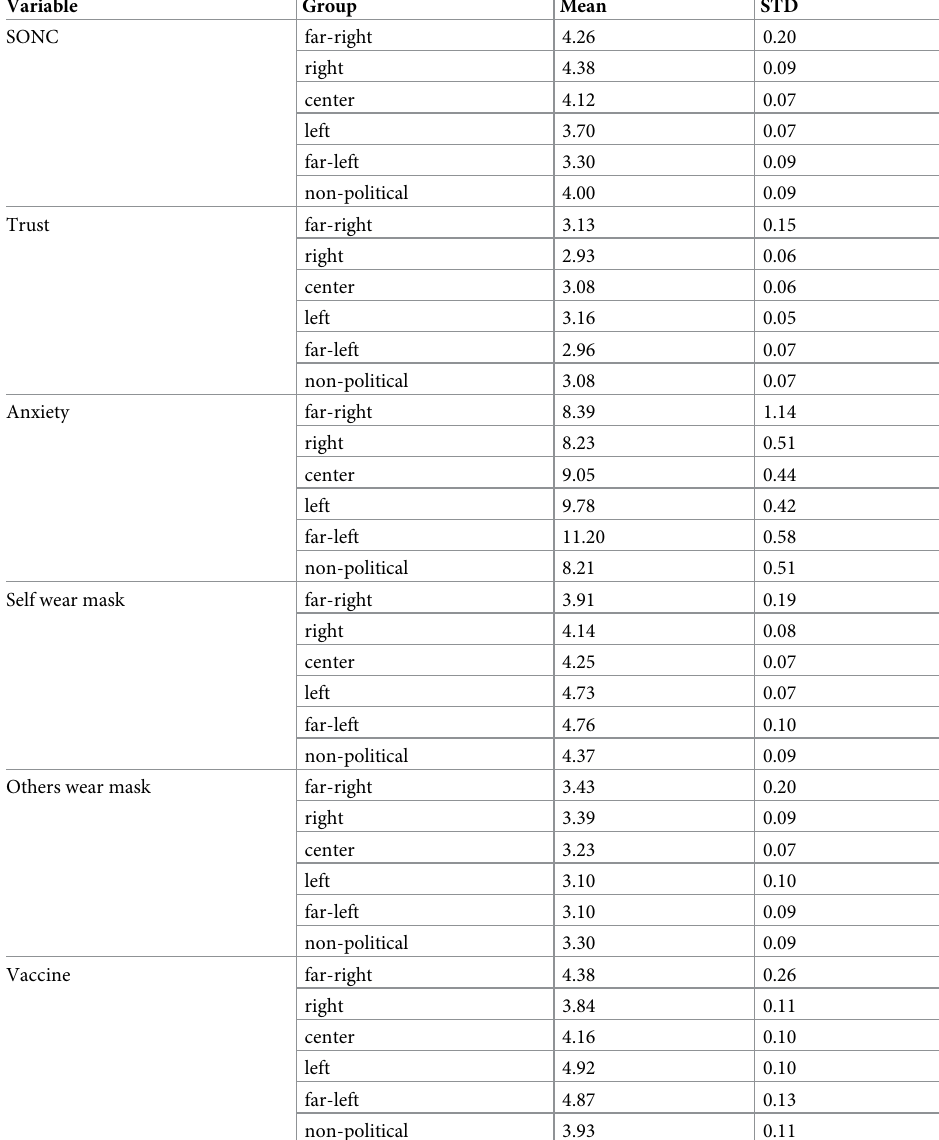
Table 2. Means, standard deviations, and ANCOVA analyses.